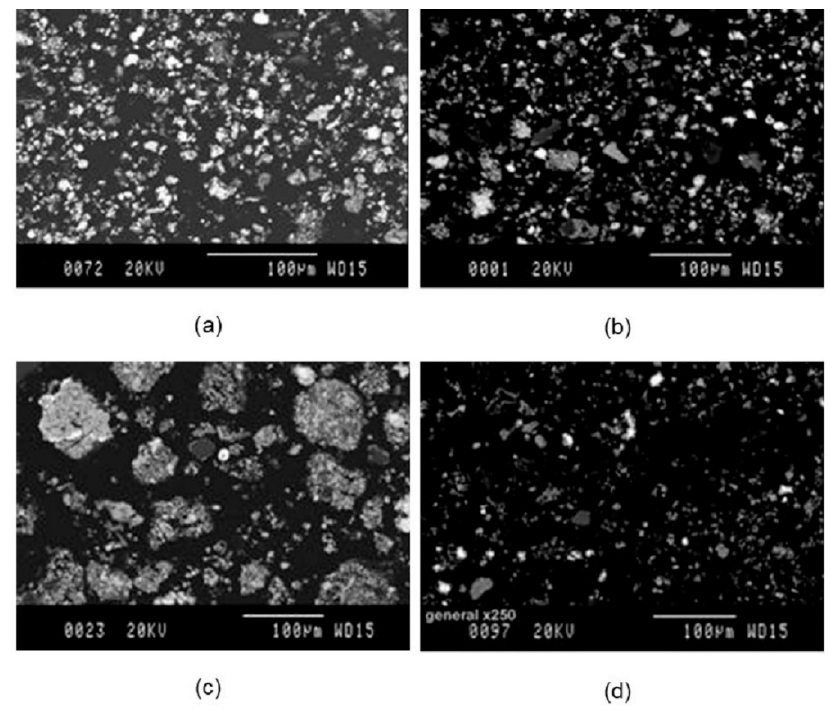
Figure 6. SEM image of leaching residue. × 350: ( a , b ). × 250: ( c , d ).